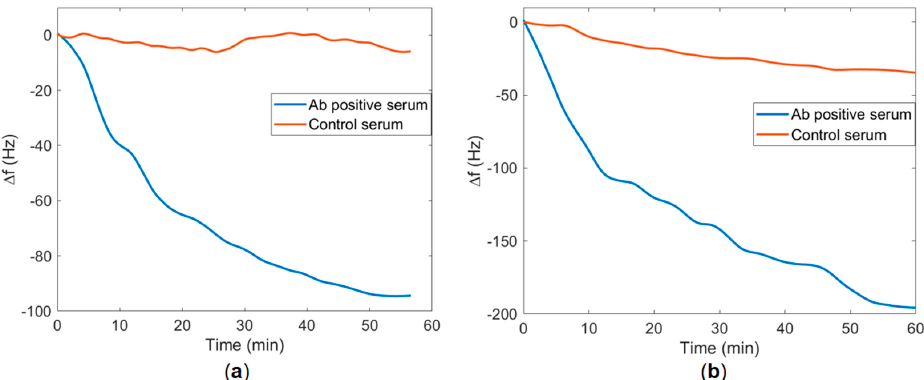
Figure 5. ∆ f versus time of COVID − 19 Ab detection by human blood serum treatment for ( a ) TBT1 and ( b ) TBT2.